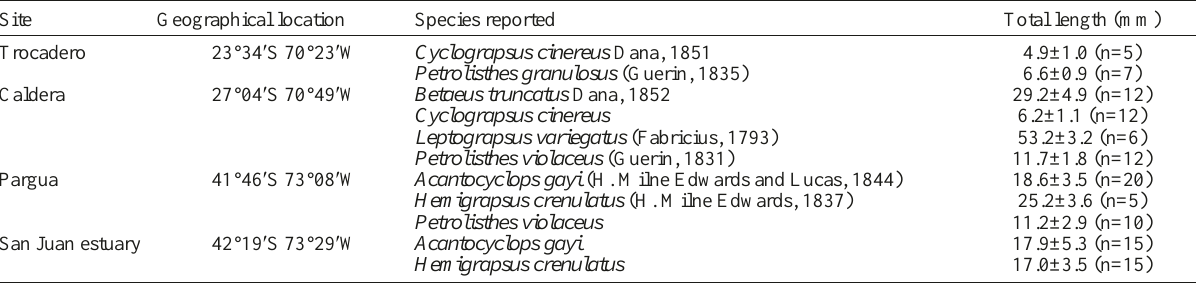
Table 1. – Geographical location, species reported and total length for species reported in sites included in the present study.